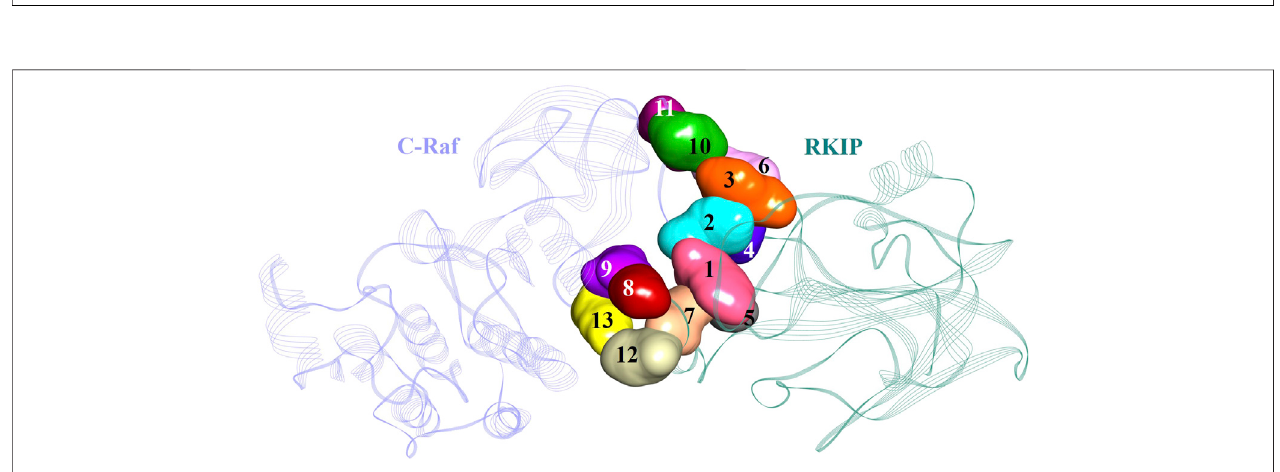
FIGURE 6 | Potential binding sites in the C-Raf/RKIP complex presented as surface with different colors in the structure.